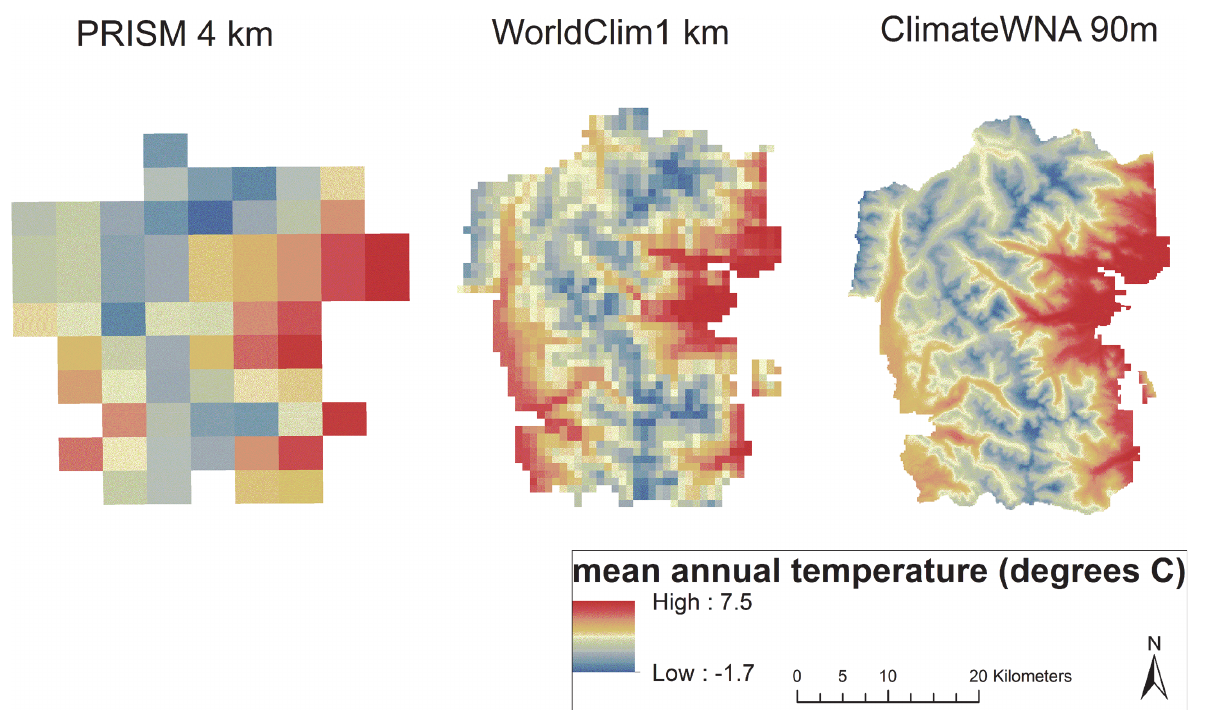
Fig 1. Comparison of mean annual temperature (MAT) at three spatial resolutions (4 km, 1 km, and 90 m) for climate normals 1981 – 2010 in Rocky Mountain National Park, Colorado. Data Sources: PRISM Climate Group (http://www.prism.oregonstate.edu/) WorldClim (http://www.worldclim.org/) and ClimateWNA